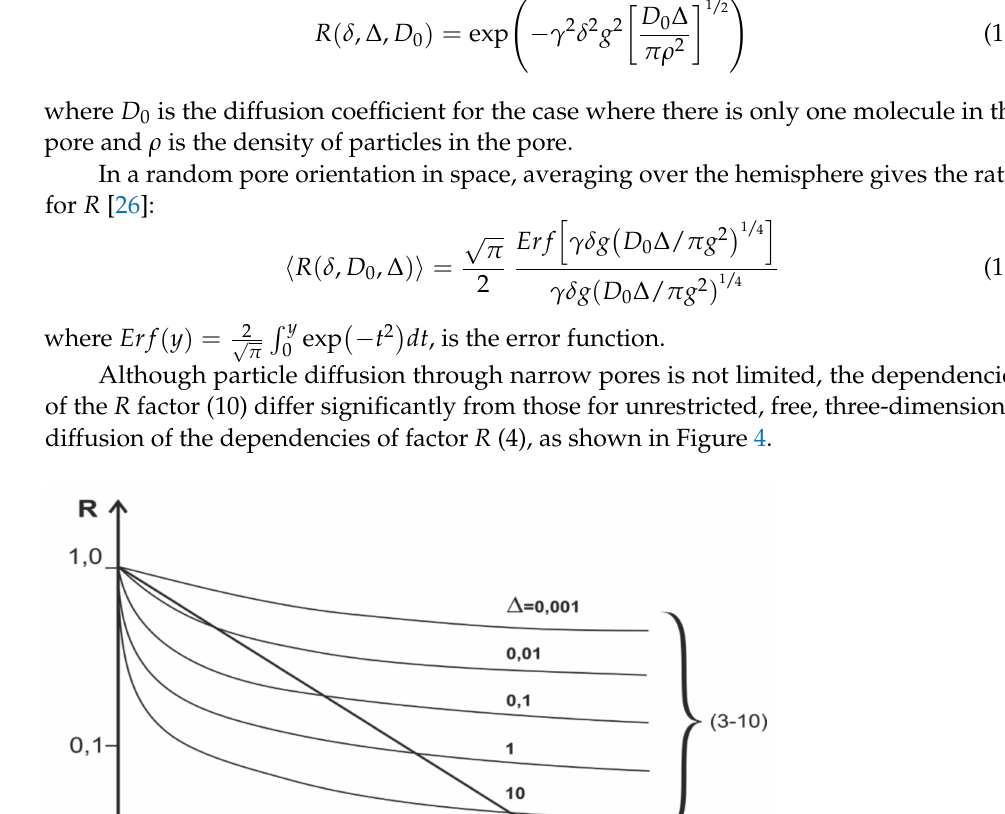
Figure 4. Schematic behavior of R factor from (straight line (4)) and through narrow pores with variation of diffusion time